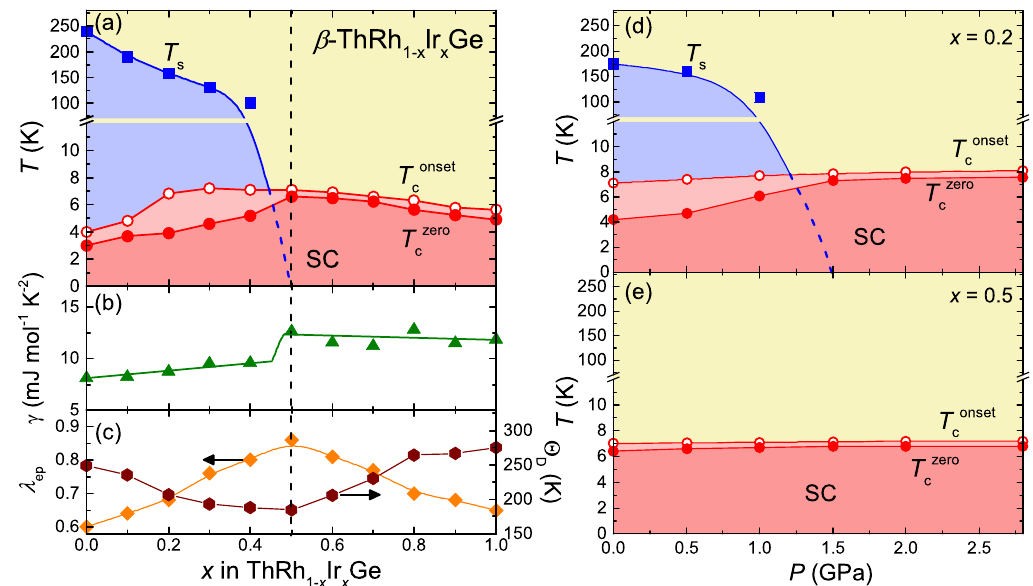
Fig. 6 Electronic and temperature-pressure phase diagrams of β -ThRh 1 − x Ir x Ge. a T - x electronic phase diagram of β -ThRh 1 − x Ir x Ge. Here T s , T onset , T zero are the structural transition, onset and offset superconducting transition temperatures, respectively. The dashed line is a guide to c c the eyes. b , c Ir content x dependencies of γ , λ ep , and Θ D , respectively, and the vertical dashed line is a guide to the eyes. d , e T - P phase diagrams for β -ThRh 1 − x Ir x Ge with x = 0.2 and 0.5, respectively. In ( d ), the dashed line is a guide to the